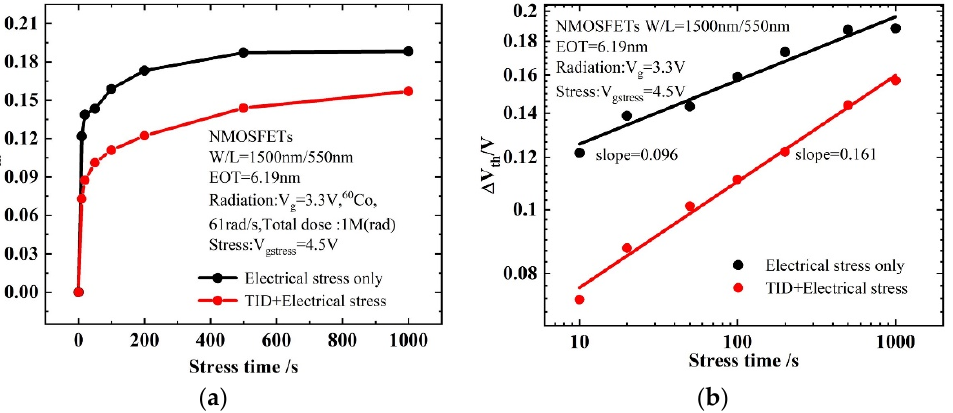
Figure 6. Degradation comparison of threshold voltage under electrical stress only and TID electri ‐ cal stress: ( a ) linear coordinates; ( b ) double logarithm coordinates.